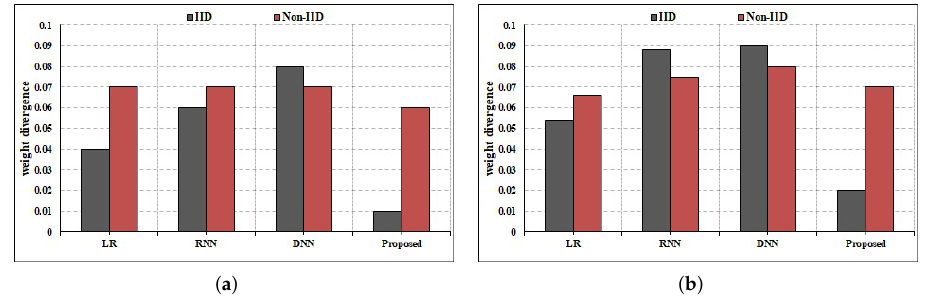
Figure 10. Weight Divergence Analysis. ( a ) GRU-Model 1, ( b ) GRU-Model